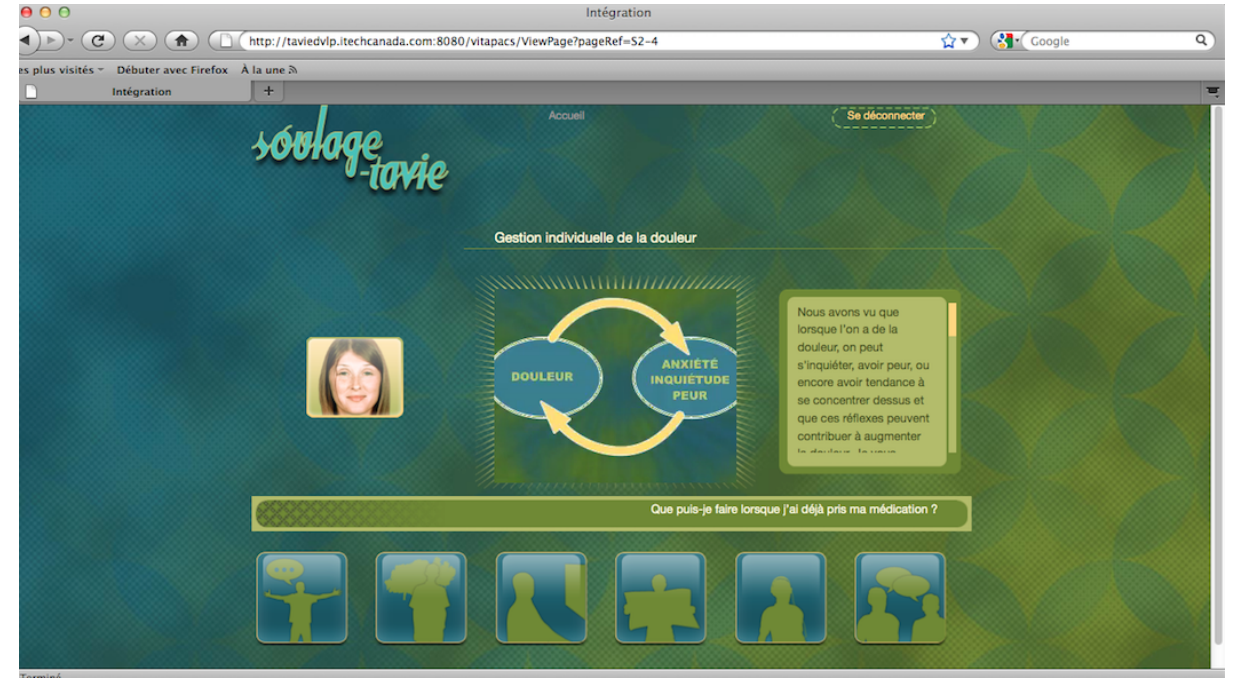
Figure 2. Animated integration page of the SOULAGE-TAVIE website displaying the nurse’s advice on pain and anxiety, and the patient’s navigation options for more